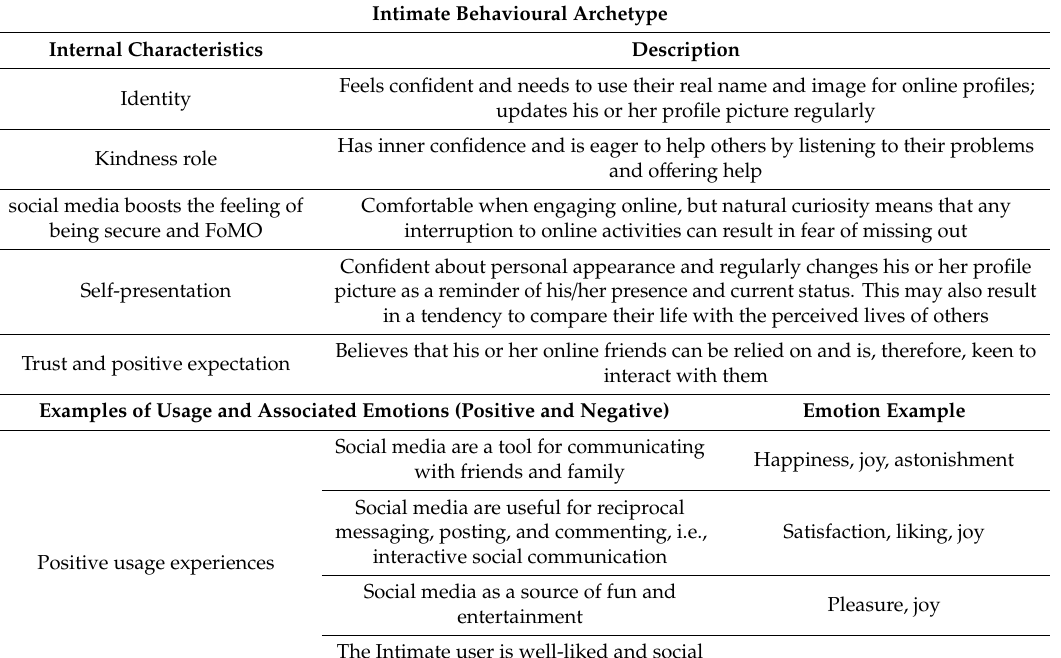
Table 6. Overview of the Intimate behavioural